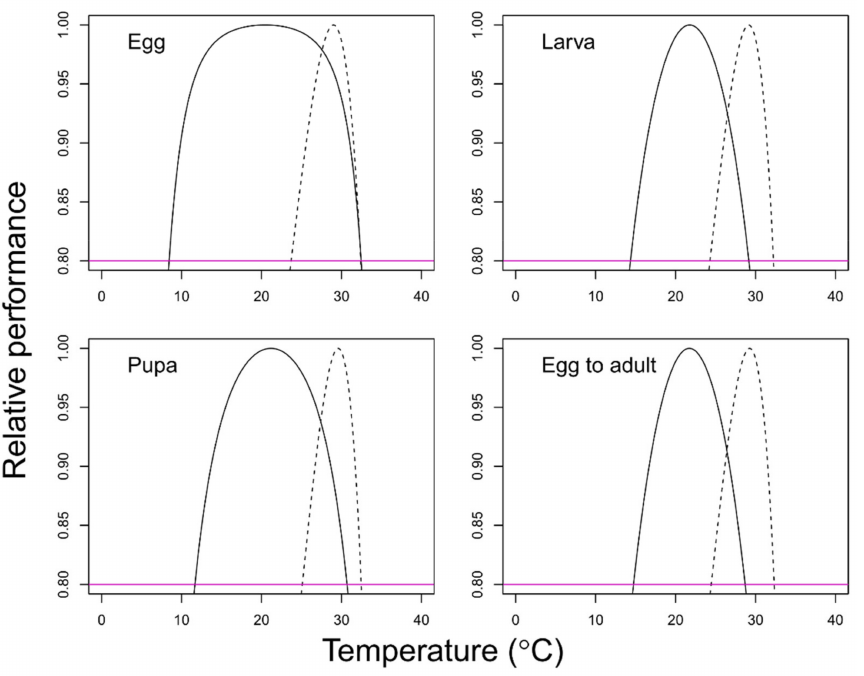
Figure 3. Temperature range expecting to show relatively good performance (> 80% of the maximum survival and development rate) for the development rates and survival of Feltiella acarisuga . Survival rate (solid lines) and development rate (dashed lines) models.